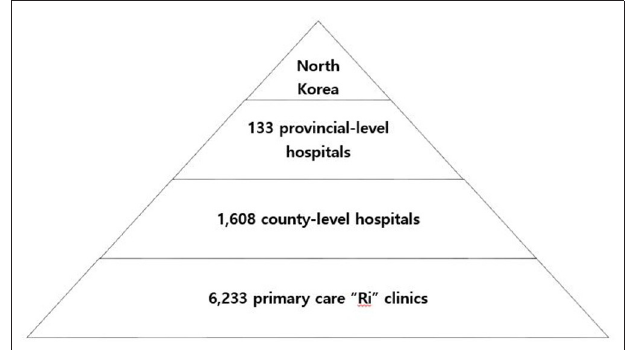
FIGURE 2 | Financial aids to DPRK from South Korea. Note the fluctuating amounts of financial aids due to the political tensions between the two nations. Source: Ministry of Unification of Republic of